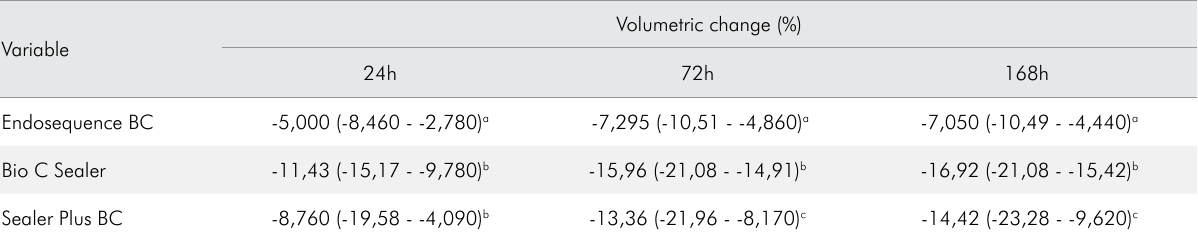
Table 2. Median, minimum and maximum values of volumetric change percentage.